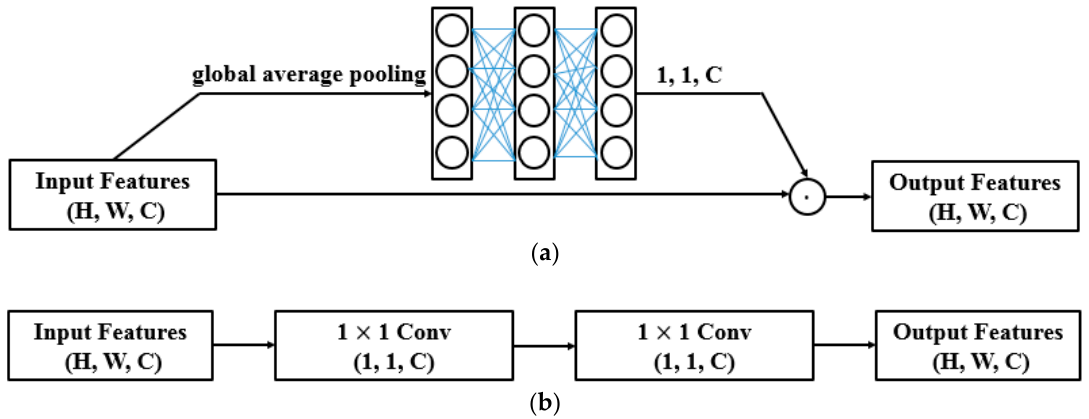
Figure 5. Feature refinement. ( a ) Squeeze-and-excitation block, ( b ) the proposed method.